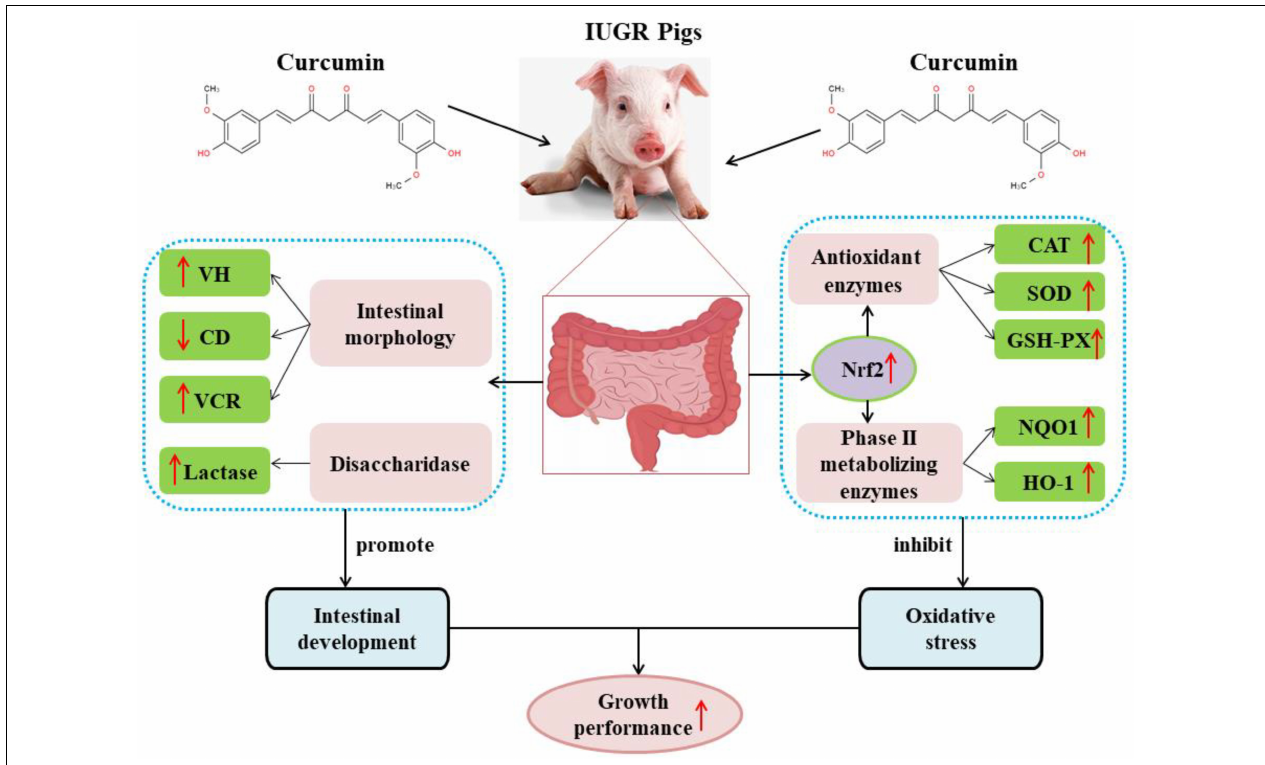
FIGURE 2 | Curcumin improved the growth performance of pigs with IUGR by improving intestinal development and alleviating intestinal oxidative stress. CAT, catalase; CD, crypt depth; GSH-Px, glutathion peroxidase; HO-1, heme oxygenase; NQO1, quinone oxidoreductase; Nrf2, nuclear factor erythroid 2-related factor 2; SOD, superoxide dismutase. VCR, the ratio of villus height to crypt depth; VH, villus